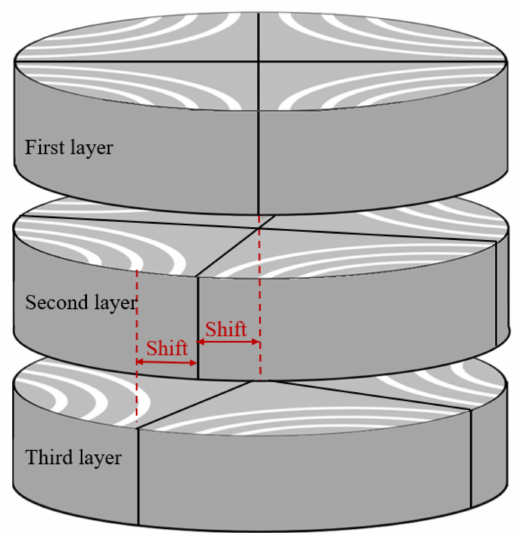
Figure 14. Instructions for applying the skew technique.